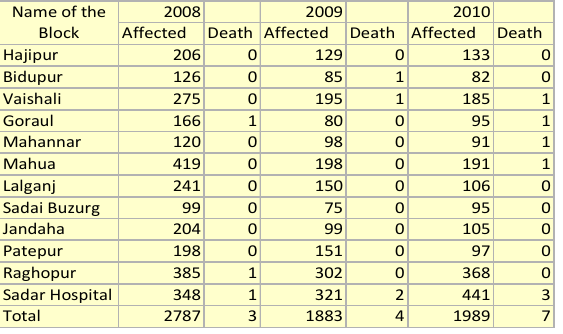
Table 1- Disease incidence in various Blocks / PHC of Vaishali District Multivariate Analysis :